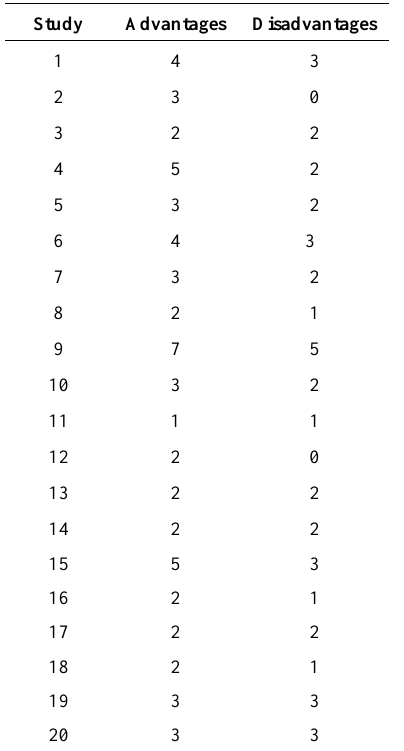
Table 2. Analysis of advantages and disadvantages.